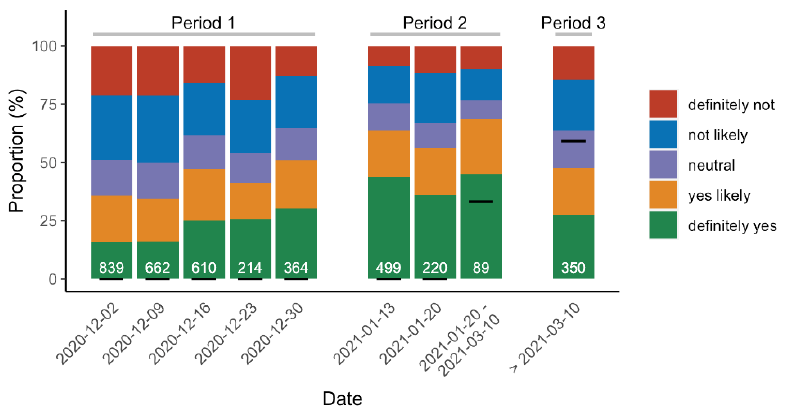
Figure 2. Time course of raw-willingness score to be vaccinated against COVID-19. White numbers represent the number of participants enrolled each week (poll time points). Participants were categorized in 5 groups according to their self-reported crude willingness to be vaccinated against COVID-19 (1 to 7 scale): definitely, yes (7), yes, likely (5–6), neutral (4), not likely (2–3), definitely, not (1). Black bars show the proportion of vaccinated respondents. Period 1: no vaccine available. Period 2: BNT162b2 mRNA vaccine available for healthcare workers >50 years and AZD1222 adenovirus vaccine for those <50 years. Period 3: BNT162b2 mRNA vaccine for any healthcare worker, and AZD1222 adenovirus vaccine for those >55 years only (after a temporary ban for safety con- cerns).